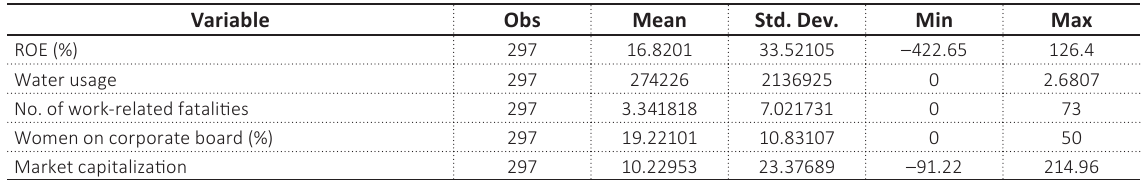
Table 1. Descriptive statistics of study